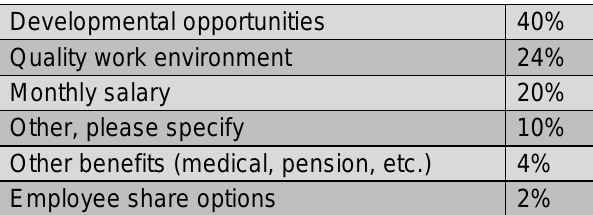
Table 3: Factors that Attracted Respondents to Current